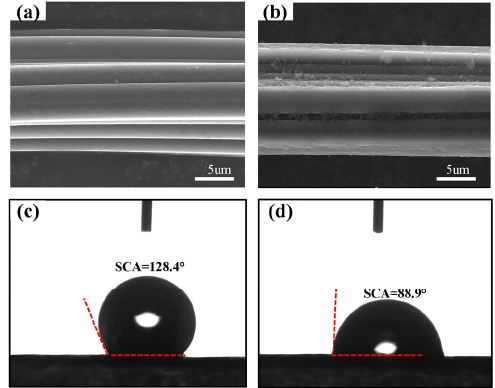
Figure 4. ( a , b ) SEM images; ( c , d ) static contact angles of CF and pDop ‐ CF surfaces.